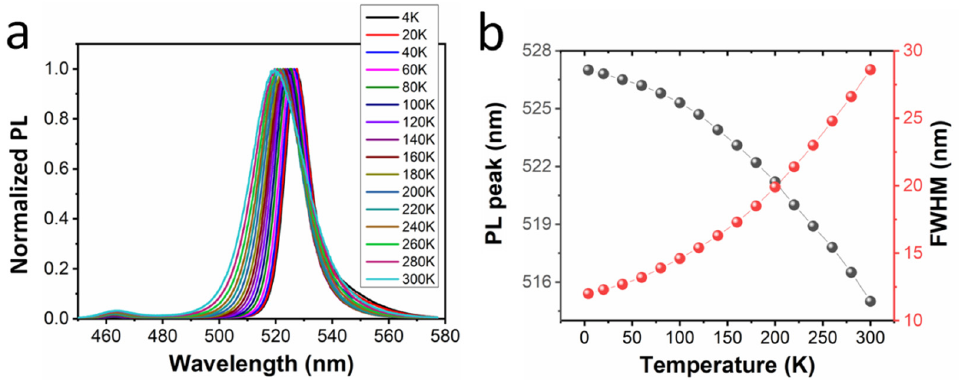
Figure 4. ( a ) Temperature-dependent PL spectra and ( b ) summarized PL peak and FWHM variations of perovskite QDs (FAPbBr 3 ).